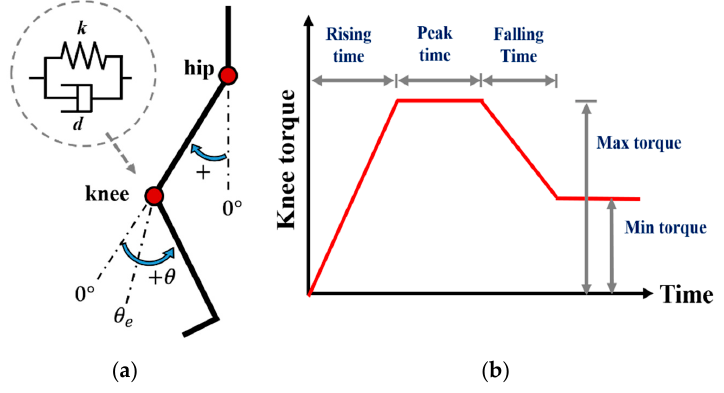
Figure 8. Control model for the knee joint. ( a ) A simple passive impedance model and the joint angle direction, and ( b ) The user-customized torque profile. Table 2. Impedance parameters for the four gait modes using the knee-actuated-exoskeletal-gait orthosis (KAEGO).